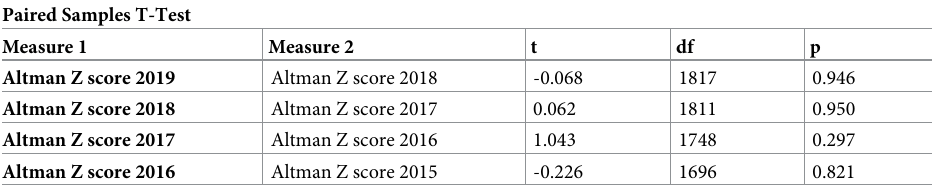
Table 7. Paired samples T-Test Altman Z score. Paired Samples T-Test